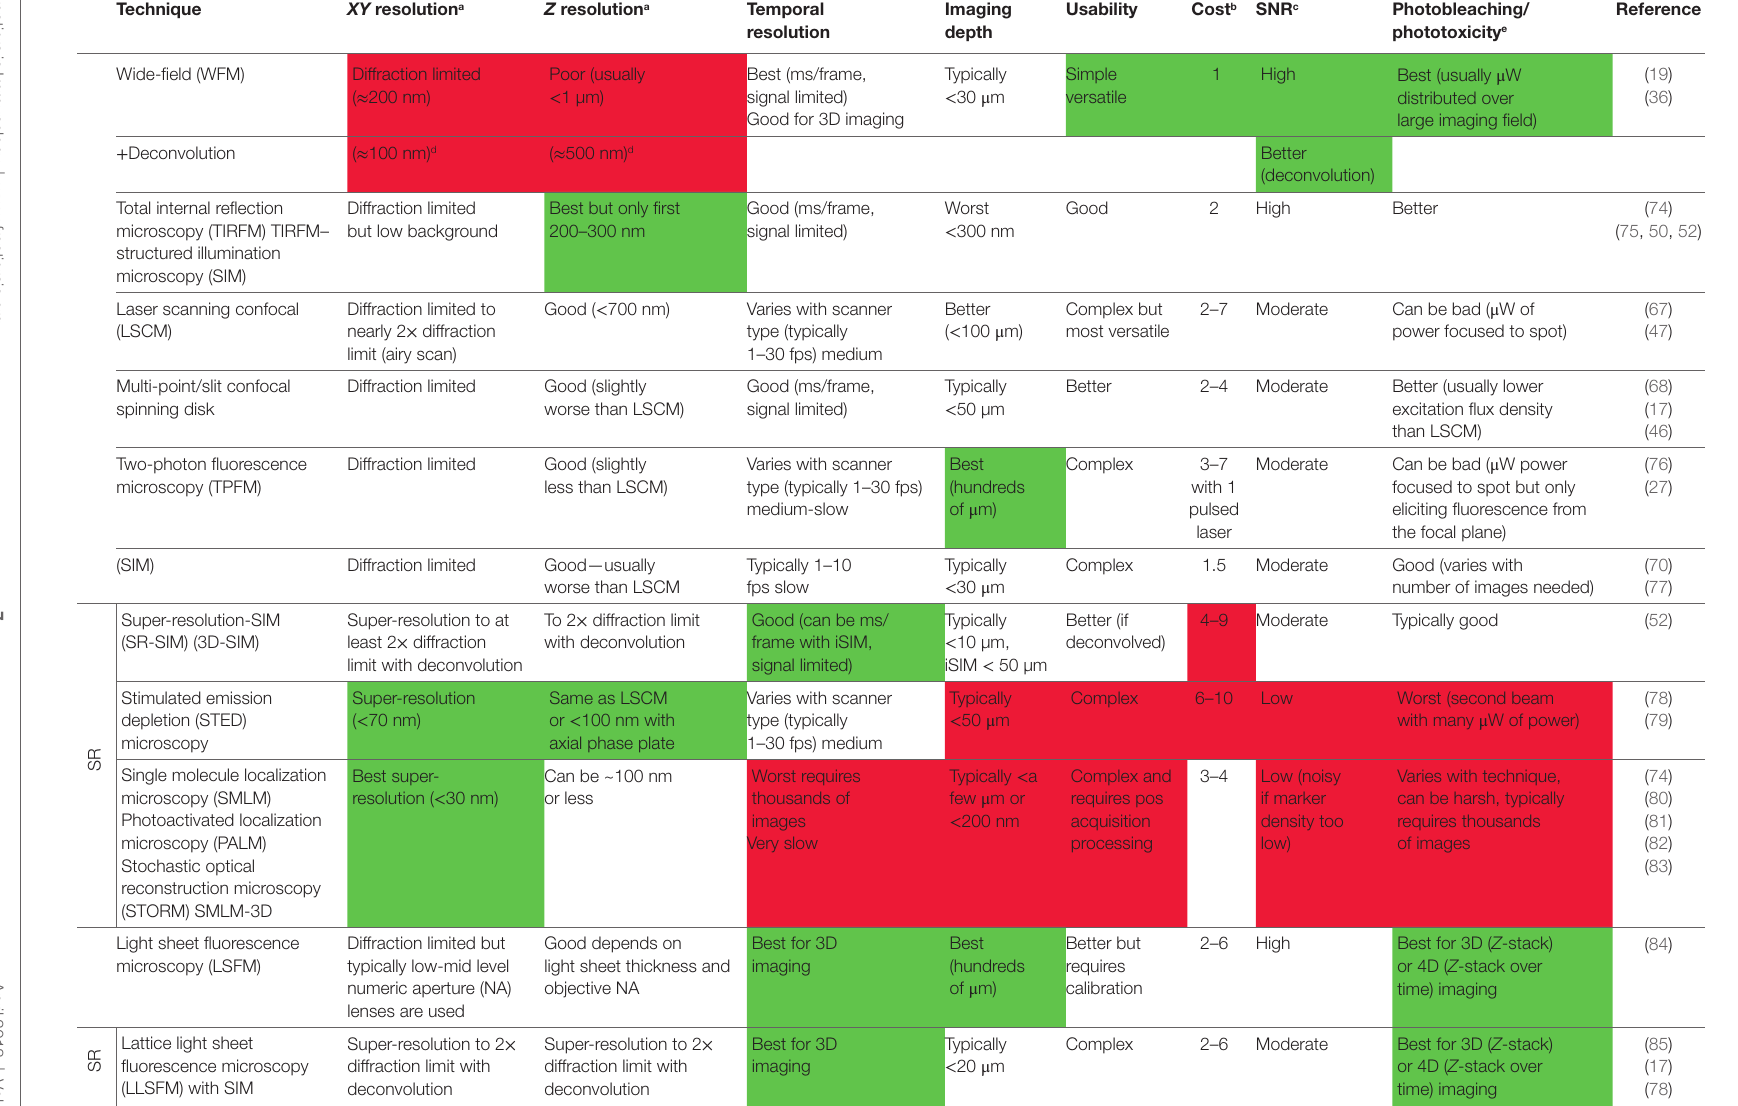
TABLe 1 | Comparison of microscopy techniques used for IS